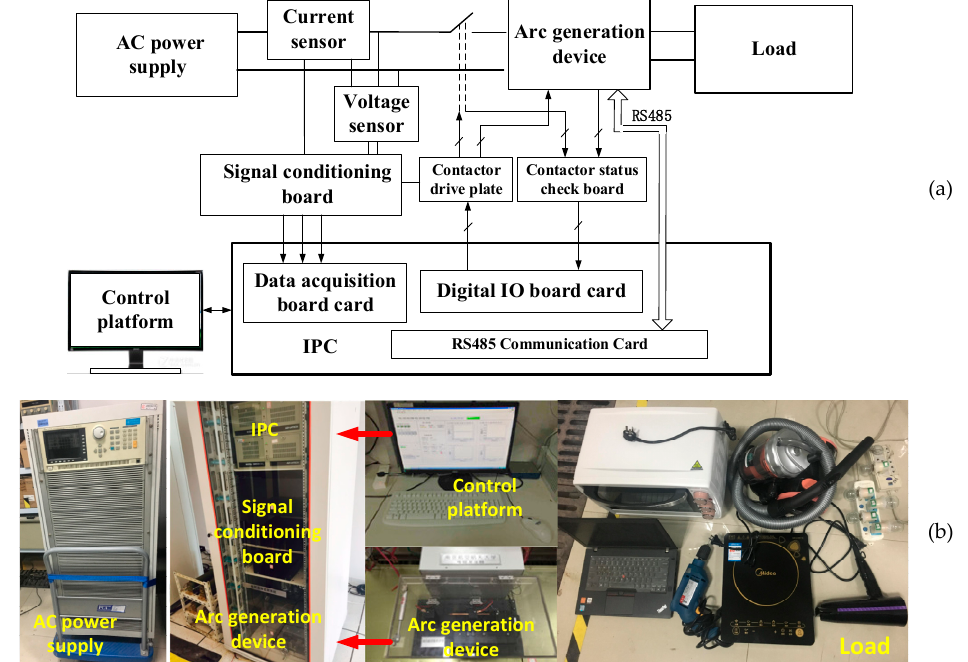
Figure 1. The arc fault experimental platform: ( a ) schematic; ( b ) actual platform.